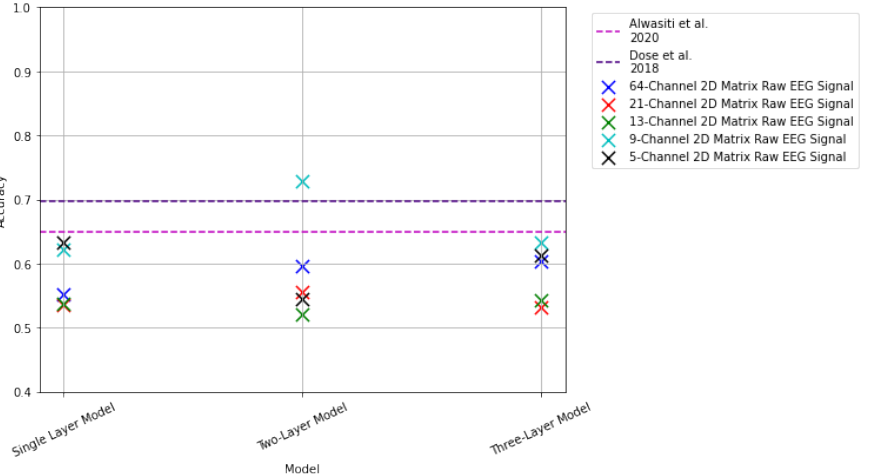
Figure 21. Results of 2D raw EEG signal representation with the 2D CNN models. The pink dashed line indicates results reported in [25]. The purple dashed line indicates results reported in [26]. Table 3. The 2D raw EEG signal for 2D CNN models results. In contrast to the image-based input, a slight increase in performance can be observed in accuracy. Most of the devised representations were able to achieve performances higher than 50%. The best results obtained with this form of input representation were obtained with the 2D raw 9- and 5-channel EEG signal sample, with an accuracy of 62.22% and 63.31% in combination with the single-layer CNN model. The three-layer CNN model with the 9- and 5-channel selections was able to reach a classification accuracy of 63.28% and 61.26% respectively. In the case of the two-layer CNN model in combination with the 64-channel selection, it was able to return a classification accuracy of 59.68%. Lastly, the only one that was able to achieve a result that outperformed the state of the art was that of the two-layer CNN model in combination with the 9-channel selection of the 2D raw EEG signal, with a classification accuracy of 72.87%. Results that outperform the state of the art are highlighted in